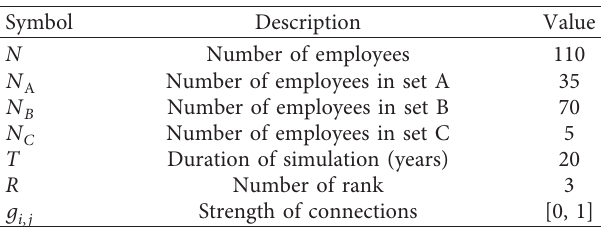
Figure 3: Zoom of connections of employee 61 at time t � 0. Table 2: The most relevant parameter values used in the